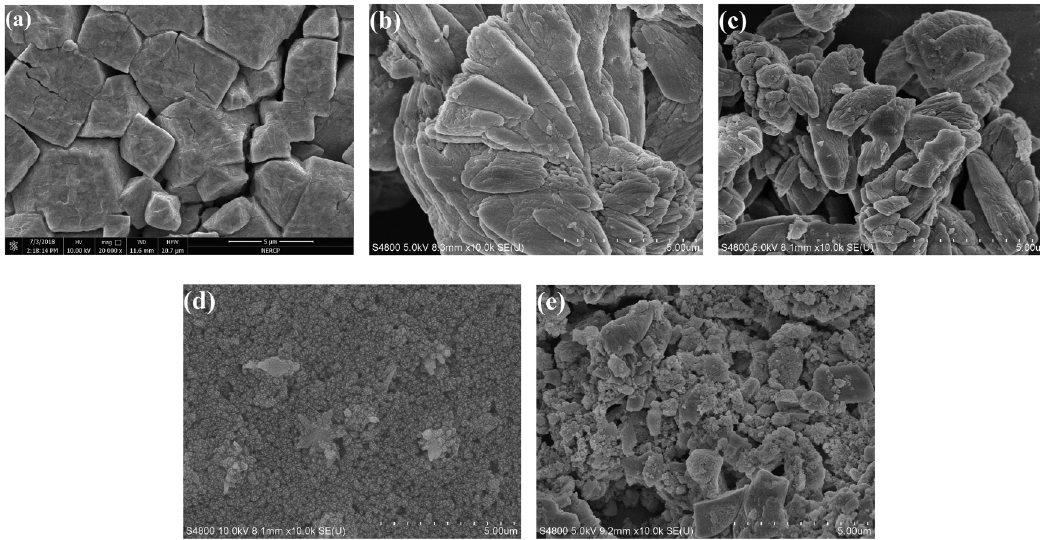
Figure 3: SEM images of ( a ) HSiW, ( b ) Ce - BDC, ( c ) HSiW@Ce - BDC, ( d ) UiO - 66 ( Zr ) , and ( e ) Ce - BDC@HSiW@UiO - 66